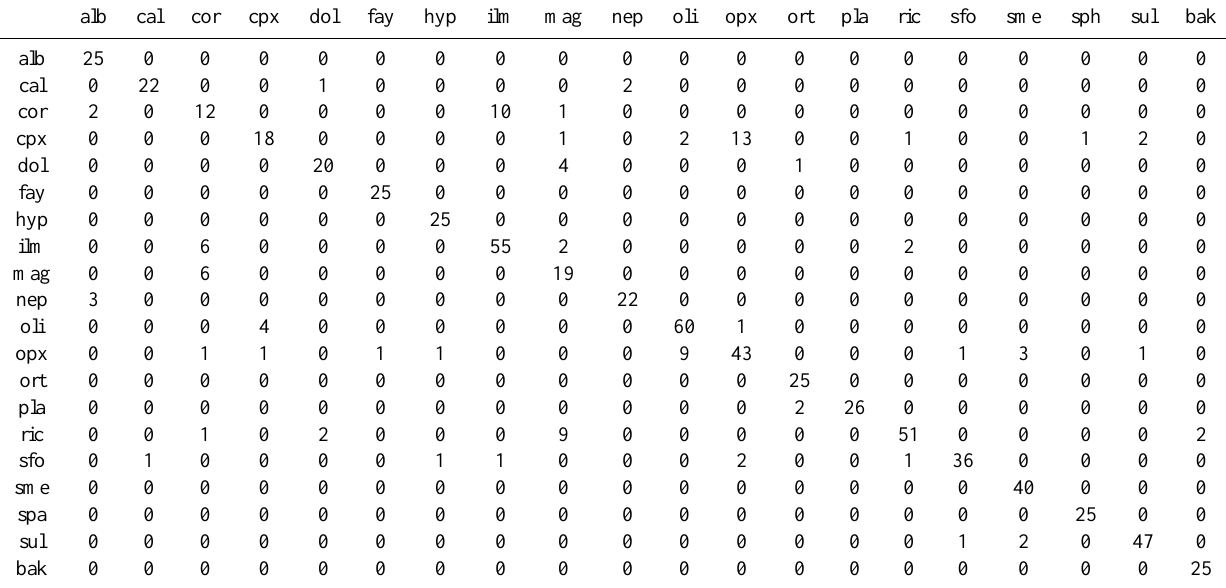
Table 4. Cross validation results for all 19 minerals and background.